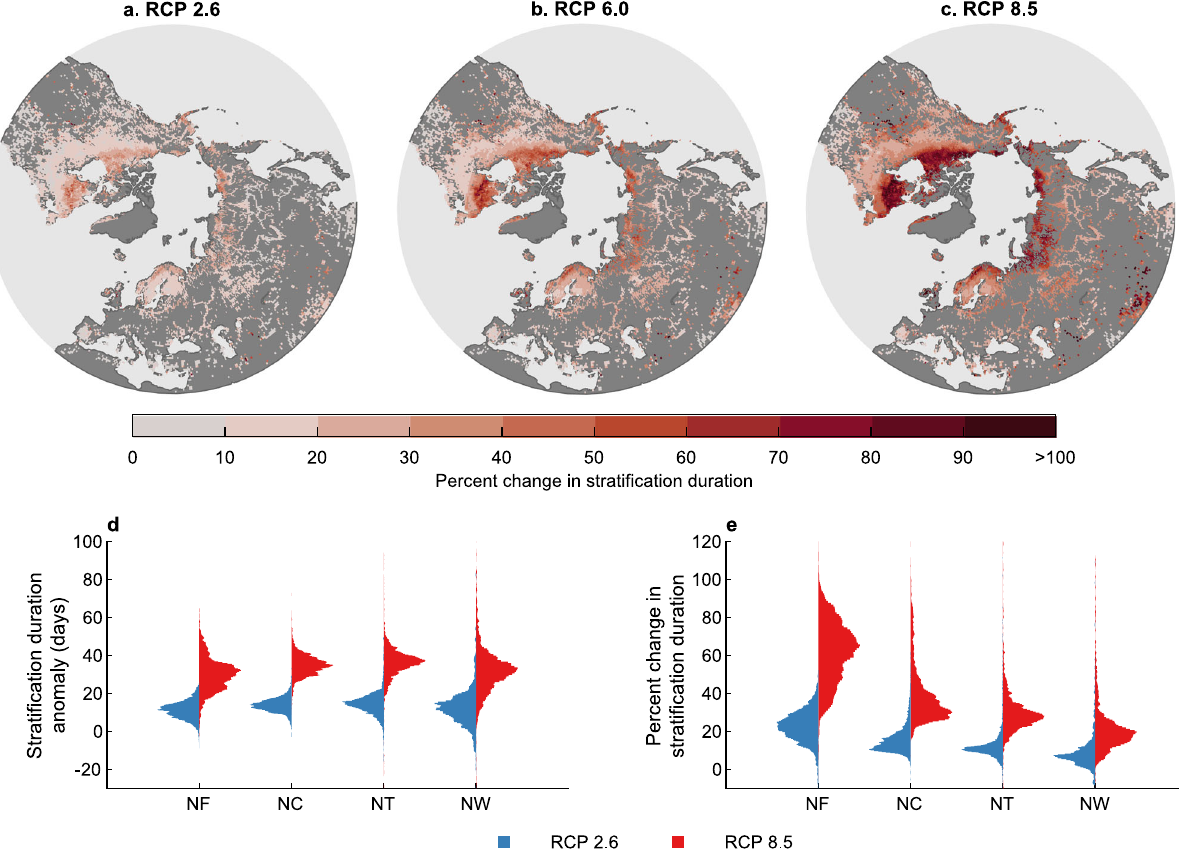
Fig. 5 Absolute and percentage change in the duration of strati fi cation during the twenty- fi rst century. Shown are the spatial patterns in the percentage change in the duration of strati fi cation by the end of the twenty- fi rst century (2070 – 2099), relative to 1970 – 1999, under a RCP 2.6, b RCP 6.0, and c RCP 8.5. Also shown, across the four dominant Northern Hemisphere lake thermal regions, are d changes in strati fi cation duration and e the percentage difference by the end of the century under RCP 2.6 and RCP 8.5. The thermal regions de fi ned include Northern Frigid (NF), Northern Cool (NC), Northern Temperate (NT), and Northern Warm (NW). The distribution of these thermal regions across the Northern Hemisphere are shown in Supplementary Fig.